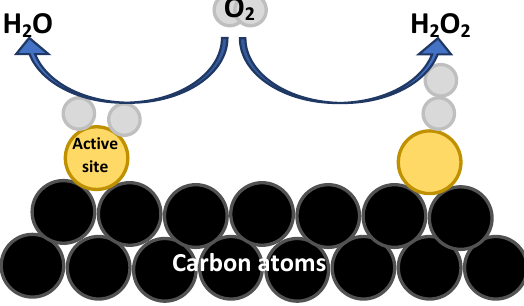
Figure 12. ORR pathways depend on the geometric structure of catalysts. Adapted from [271].